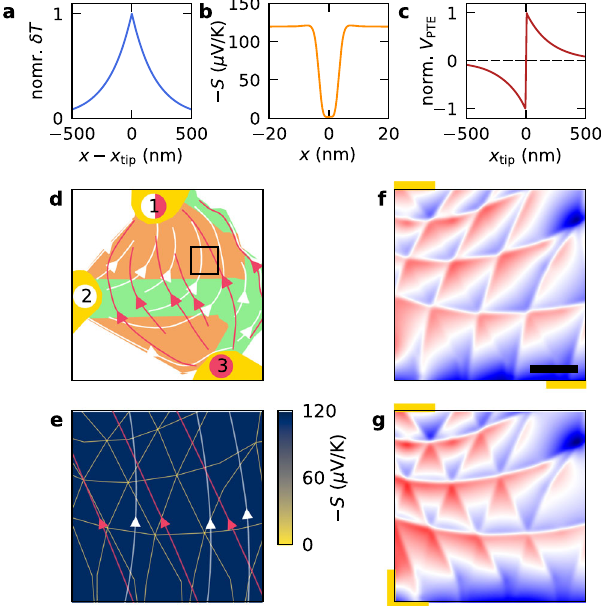
Fig. 3 Simulations of the photo-thermoelectric response in mTBG. a Pro fi le of the electron temperature increase induced by local photoexcitation as a function of distance ( x ) from the excitation position ( x tip ), for a cooling length of 200 nm. b Calculated Seebeck coef fi cient as a function of position within two moiré unit cells separated by a domain wall at x = 0 nm. c Line trace of the calculated photovoltage across a domain wall using the thermal pro fi le and Seebeck coef fi cient of a and b . d Illustration of the geometry used in our photocurrent simulations. The yellow semi-circles indicate contact probes, the green single-layer graphene regions and the orange mTBG regions. The red projection of current fl ows corresponds to a con fi guration wherein current fl ows between contacts 3 and 1, while the white fi eld lines correspond to the current fl owing between contacts 2 and 1. The black square highlights the region shown in e – g . e 2D spatial map of the calculated Seebeck coef fi cient (Supplementary Note 6) that goes into our model, along with the projections of current fl ows shown in d . f Zoom of the photovoltage simulations in the region of mTBG (same area as Fig. 2a). Here we convolute the calculated responsivity with a Gaussian function of width 15 nm to account for the fi nite tip radius. Colour code: blue: − 1, red: + 1. Length of scale bar: 500 nm. g Same as in f but for a different measurement geometry (same as Fig.